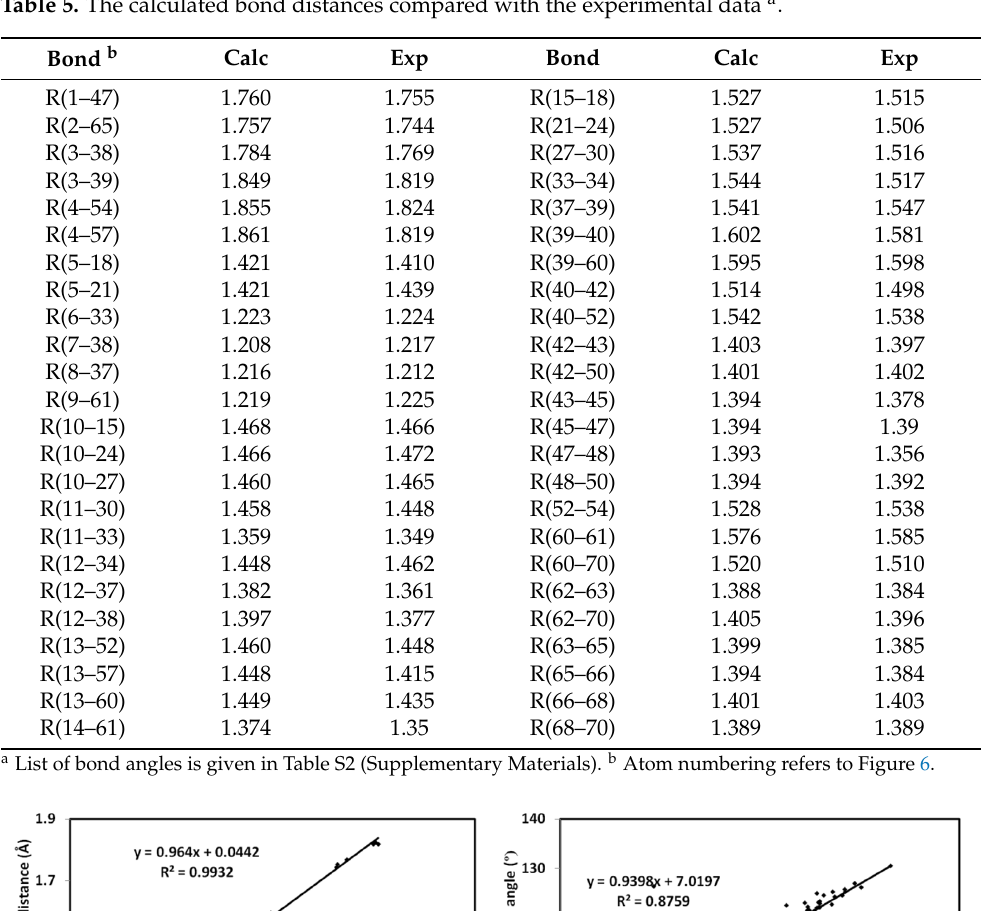
Table 5. The calculated bond distances compared with the experimental data a .